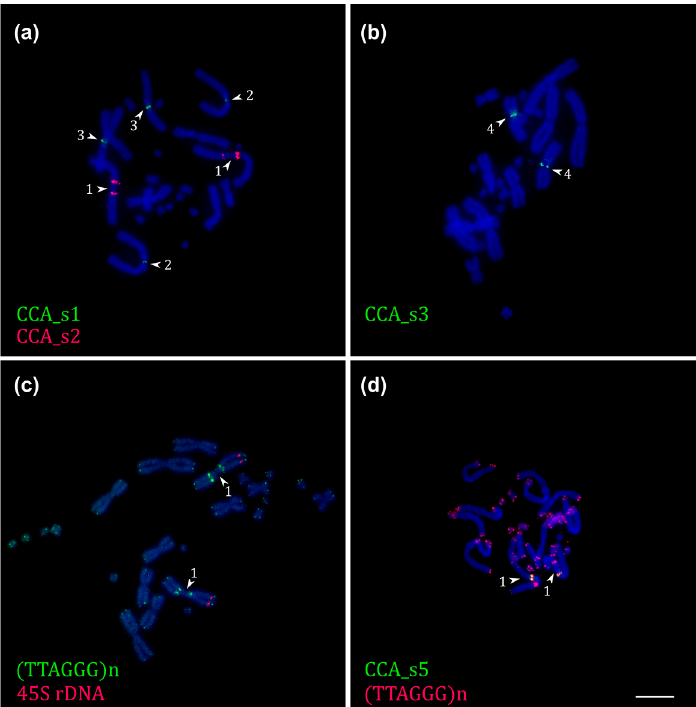
Figure 4. Fluorescent in situ hybridization of C. calyptratus repetitive element probes on its metaphase plates. Chromosomes are indicated by the arrowheads. Co-localization of probes are shown: ( a ) CCA_s1 (green) and CCA_s2 (red); ( b ) CCA_s3 (green); ( c ) (TTAGGG)n (green) and 45S rDNA (red); ( d ) CCA_s5 (green) and (TTAGGG)n (red). Scale bar = 10 um.